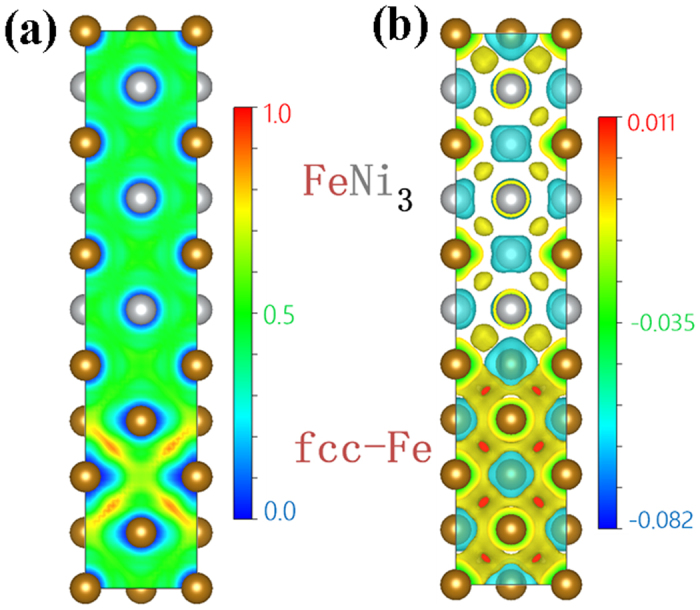
(a) Electron localization function (ELF) and (b) electron-density difference of Fe & FeNi3 supercell.